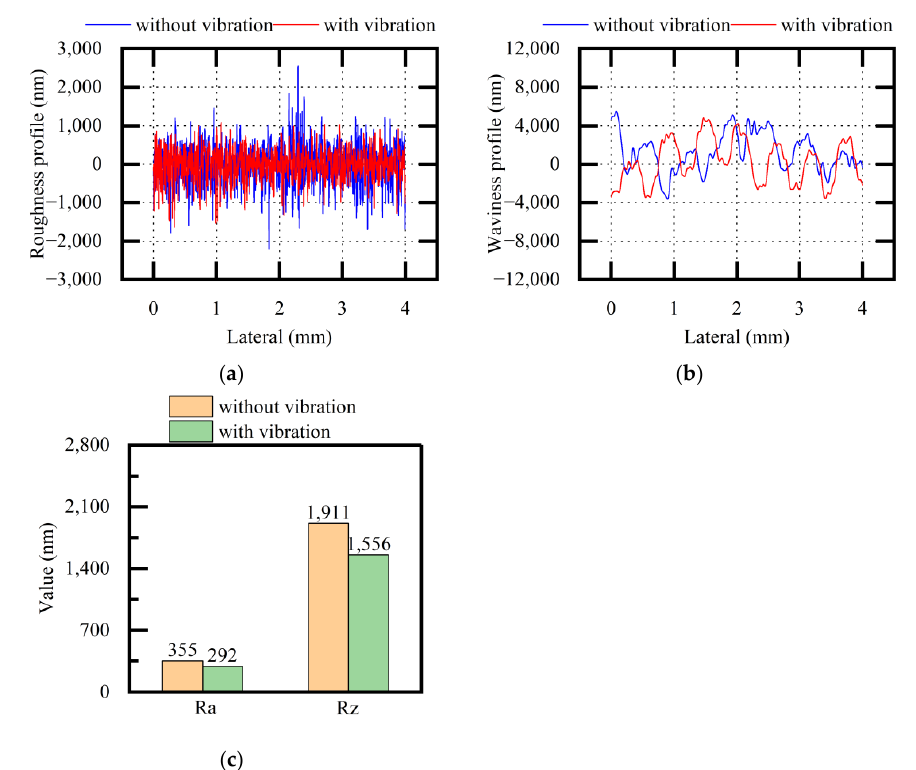
Figure 14. Comparative analysis of surface quality (NdFeB, variable f ): ( a ) roughness profile; ( b ) waviness profile; ( c ) average values of Ra and Rz.